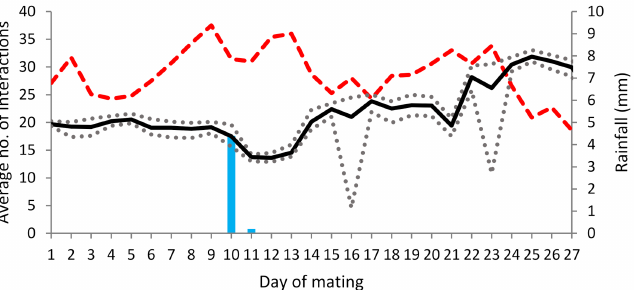
Figure 1. The average number of interactions for all rams across all ewes each day ( - ), the maximum and minimum number of interactions for all rams across all ewes each day ( . . . ), the maximum temperature ◦ C (- - -) and rainfall ( ) recorded over 27 days grazing dry